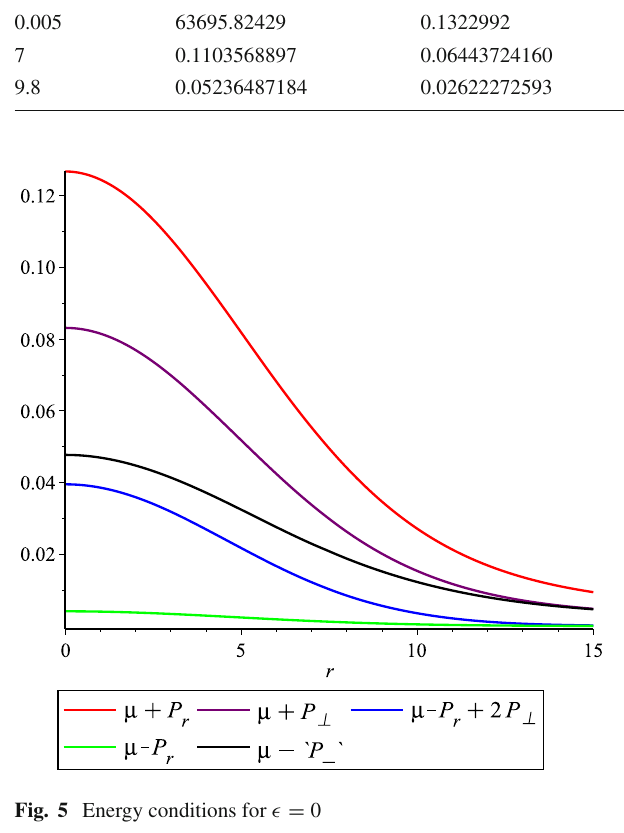
Fig. 5 Energy conditions for (cid:2) = 0